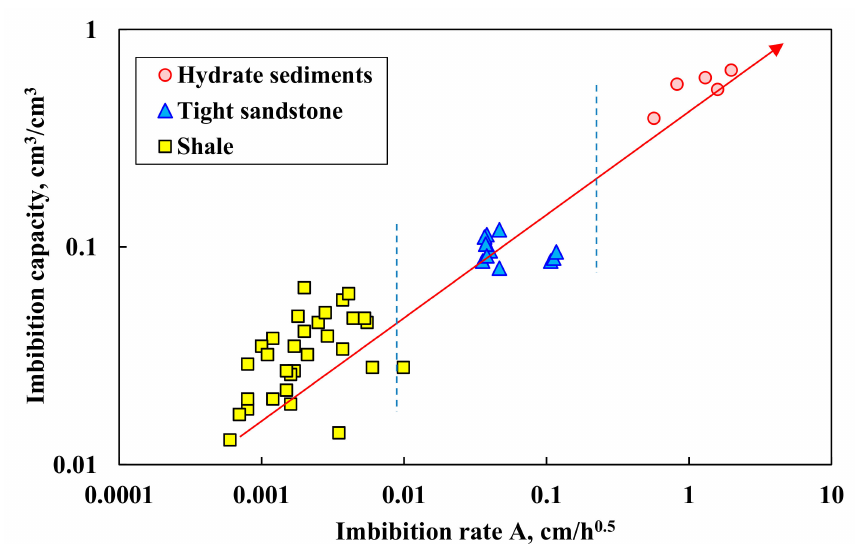
Figure 11. Comparison of hydrate sediments and other formations. The experimental results of tight sandstone and shale are cited from Ge et al.